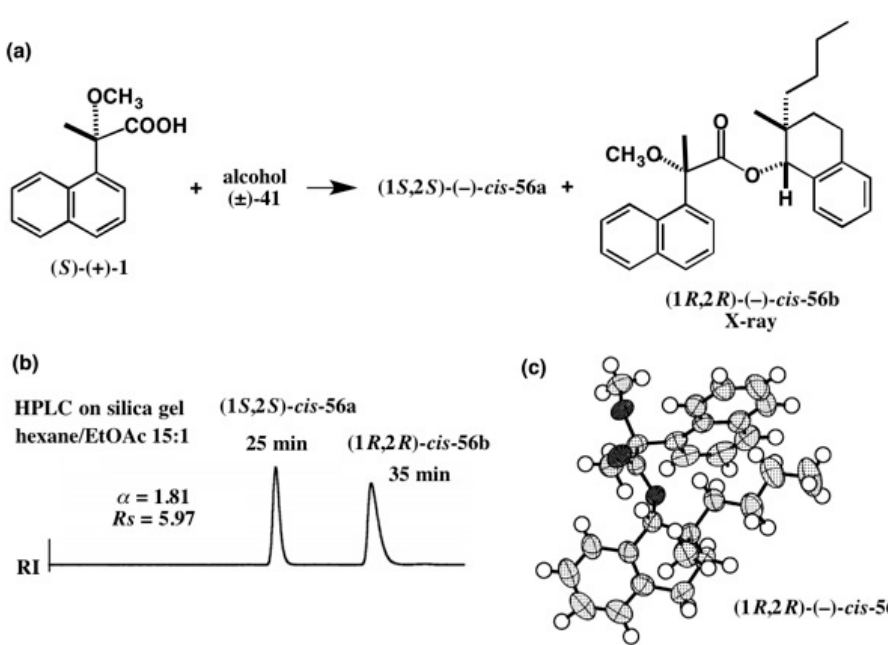
Figure 39. Preparation ( a ) and HPLC separation ( b ) of M α NP esters 56a and 56b . HPLC, reprinted with permission from [45]. ( c ) X-ray ORTEP drawing of M α NP ester (1 R ,2 R )-( − )- cis - 56b , reprinted with permission from [57].